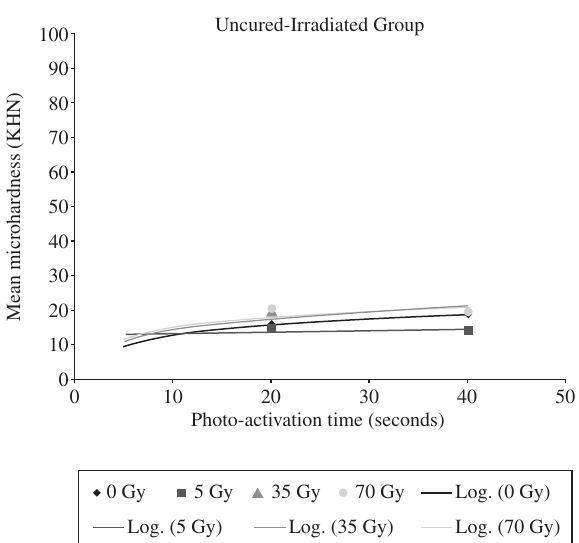
Figure 6. Regression analysis of microhardness averages of the Fill Magic Flow ® material to cured-irradiated groups in accordance with radiation dose as a function of the photo-activation